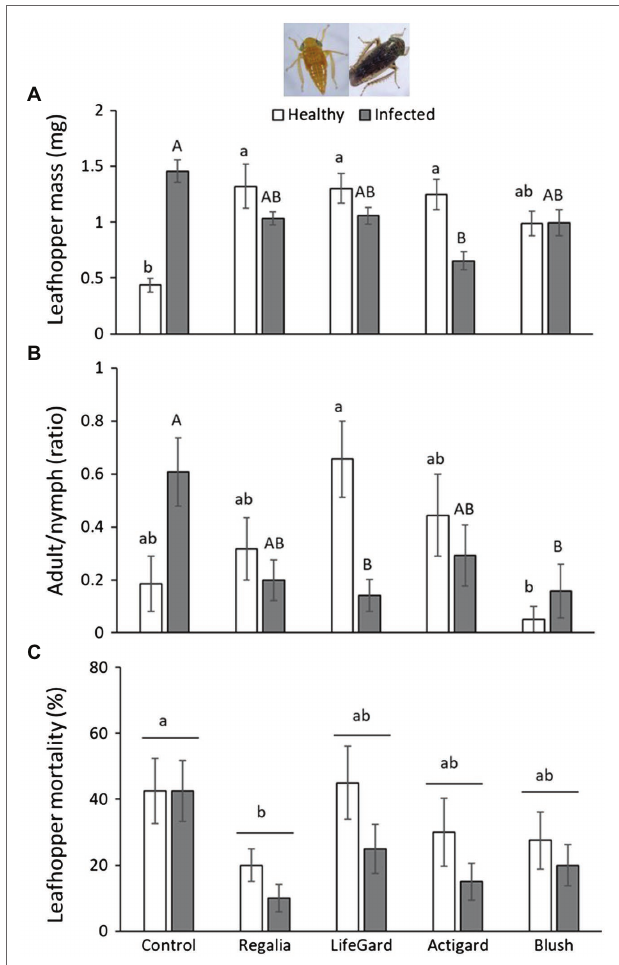
FIGURE 3 | Effects of phytoplasma infection and elicitor treatments on Limotettix vaccinii mass (A) , ratio of adults vs. nymphs (B) , and percent mortality (C) . Data are means ± SE . Different lowercase letters above bars indicate that means among elicitor treatments differ for uninfected (healthy) plants, and different uppercase letters show treatment differences for infected plants (Tukey’s HSD tests, p ≤ 0.05). Control plants did not receive any elicitor (i.e., treated with distilled water only). n = 10 replicates per infection/treatment combination.